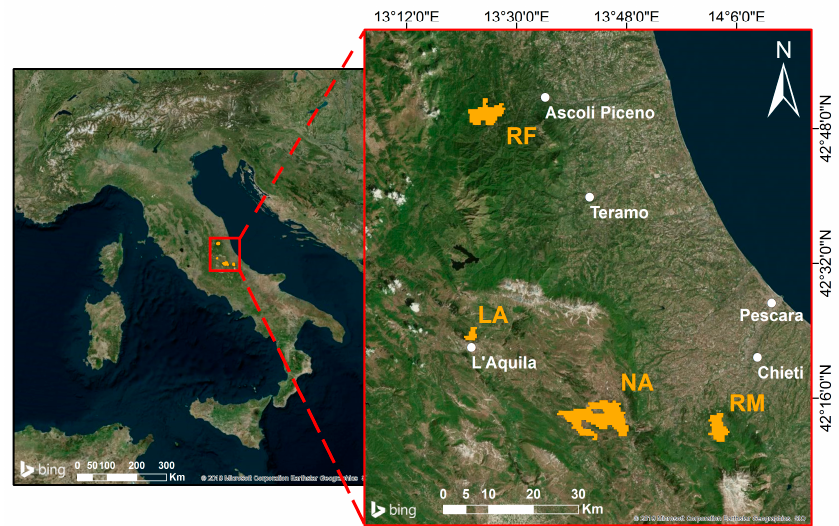
Figure 1. Location and wildfire surface (orange polygons) from MODIS burned area (MCD64A1) of the four study areas: Roccafluvione (RF), L’Aquila (LA), Navelli (NA), and Roccamorice (RM). Table 1. Wildfire information, and climate and landform properties of the four study areas: